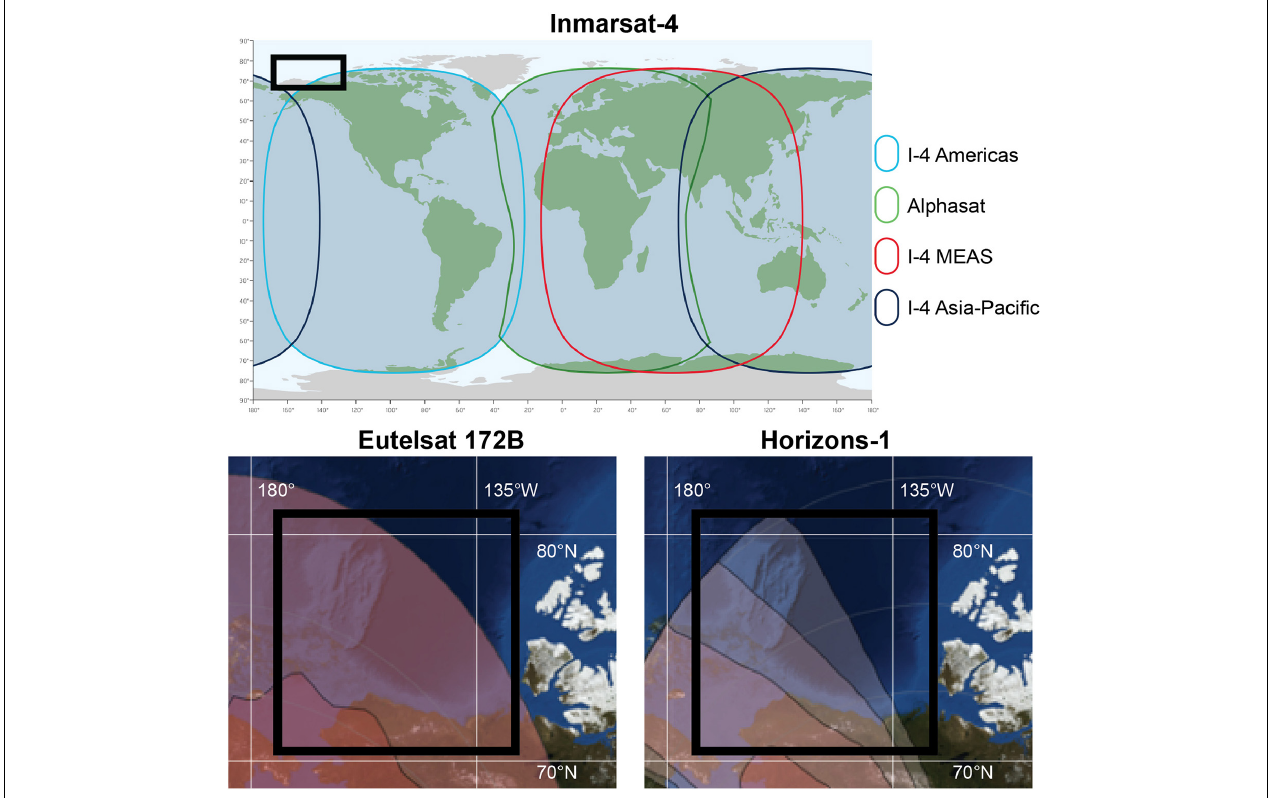
FIGURE 3 | Map of Ku band coverage projection from (top) the Inmarsat constellation, from inmarsat.com, for (bottom left) Eutelsat 172B North Pacific Ku-band transceiver. Increasingly red shades indicate larger relative effective radiative transmit power of the satellite (signal strength). SODA operation region is highlighted (black rectangles).